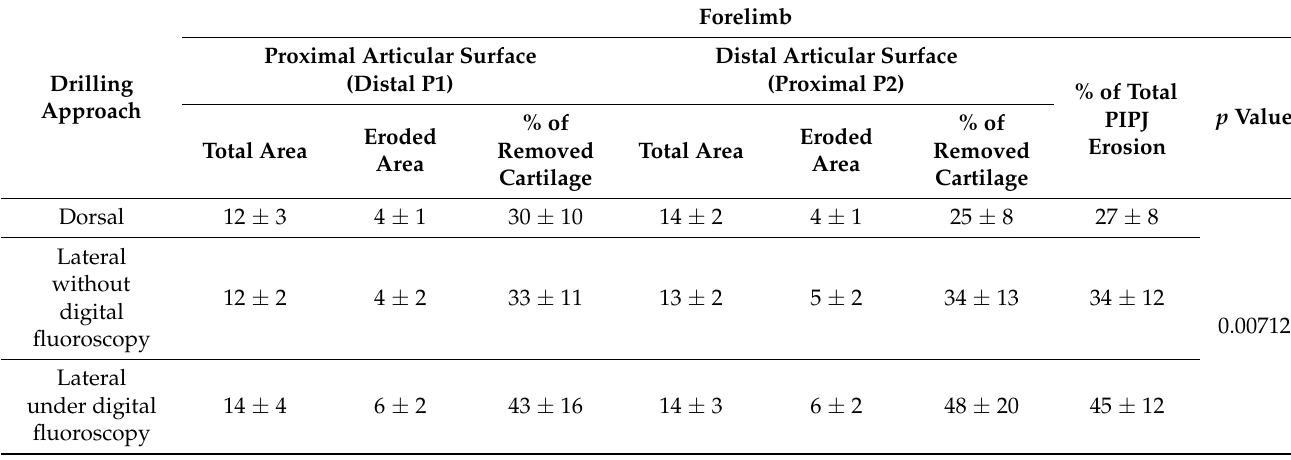
Table 1. Mean ± SD total area (cm 2 ), eroded area (cm 2 ) and percentage of removed cartilage in proximal and distal articular surfaces of the proximal interphalangeal joint (PIPJ) in the forelimb. Comparison of the three techniques.